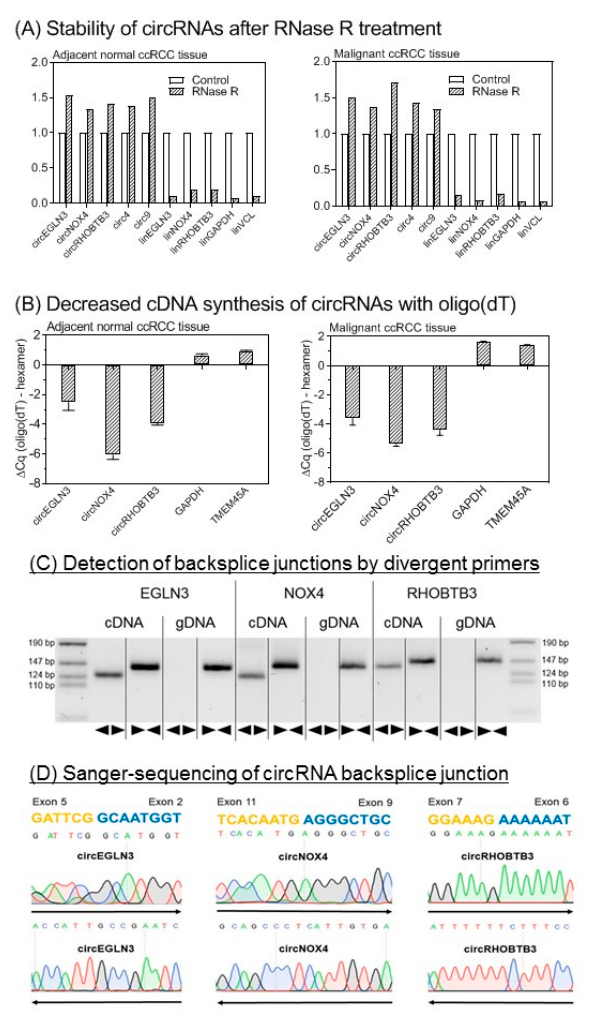
Figure 3. Analytical validation of the circular nature of circEGLN3, circNOX4, and circRHOBTB3. ( A ) Stability of circular RNAs (circRNAs) after RNase R treatment. CircRNAs are stable while linear mRNAs are degraded when treated with RNase R. Glyceraldehyde 3-phosphate dehydrogenase (GAPDH) mRNA (glyceraldehyde-3-phosphate dehydrogenase), VNL mRNA (vinculin), circ4, and circ9 were used as additional controls [13,31]. Data of triplicate experiments normalized to controls without RNase treatment are presented. ( B ) Random hexamer vs. oligo(dT) primers for cDNA synthesis. Random hexamer primers are used for amplification during cDNA synthesis of circRNAs as covalently closed structures of circRNAs lack a poly-A-tail. The binding capacity of oligo(dT) primers is therefore reduced without polyadenylated binding sites. In consequence, quantitation cycle ( Δ Cq) values in RT-qPCR are distinctly reduced when using random hexamer primers in comparison to oligo(dT) primers for circRNA cDNA synthesis. GAPDH and TMEM45A (transmembrane protein 45A) were used as mRNA controls. Significantly different mean values between the six circRNA samples and four mRNAs of GAPDH and TMEM45A as mRNA controls (mean values: − 4.33 vs. 1.18, p < 0.0001) confirmed this characteristic feature of circRNAs. Different mean values of the circRNAs between the tissues were not observed ( p > 0.799). ( C ) Gel electrophoresis of PCR products obtained from cDNA and genomic DNA (gDNA). Divergent ( ◄► ) primers used for circRNA measurements amplify sequences only in cDNA. Convergent ( ►◄ ) primers show amplification of circRNA composing exons in cDNA and gDNA. ( D ) Base sequence of circRNA backsplice junction pictured by Sanger sequencing. Sanger sequencing was performed with forward ( → ) and reverse ( ← ) primers. Methodical details for all here listed experiments are described in section “Material and Methods” and in Supplementary Information with Supplemental Table